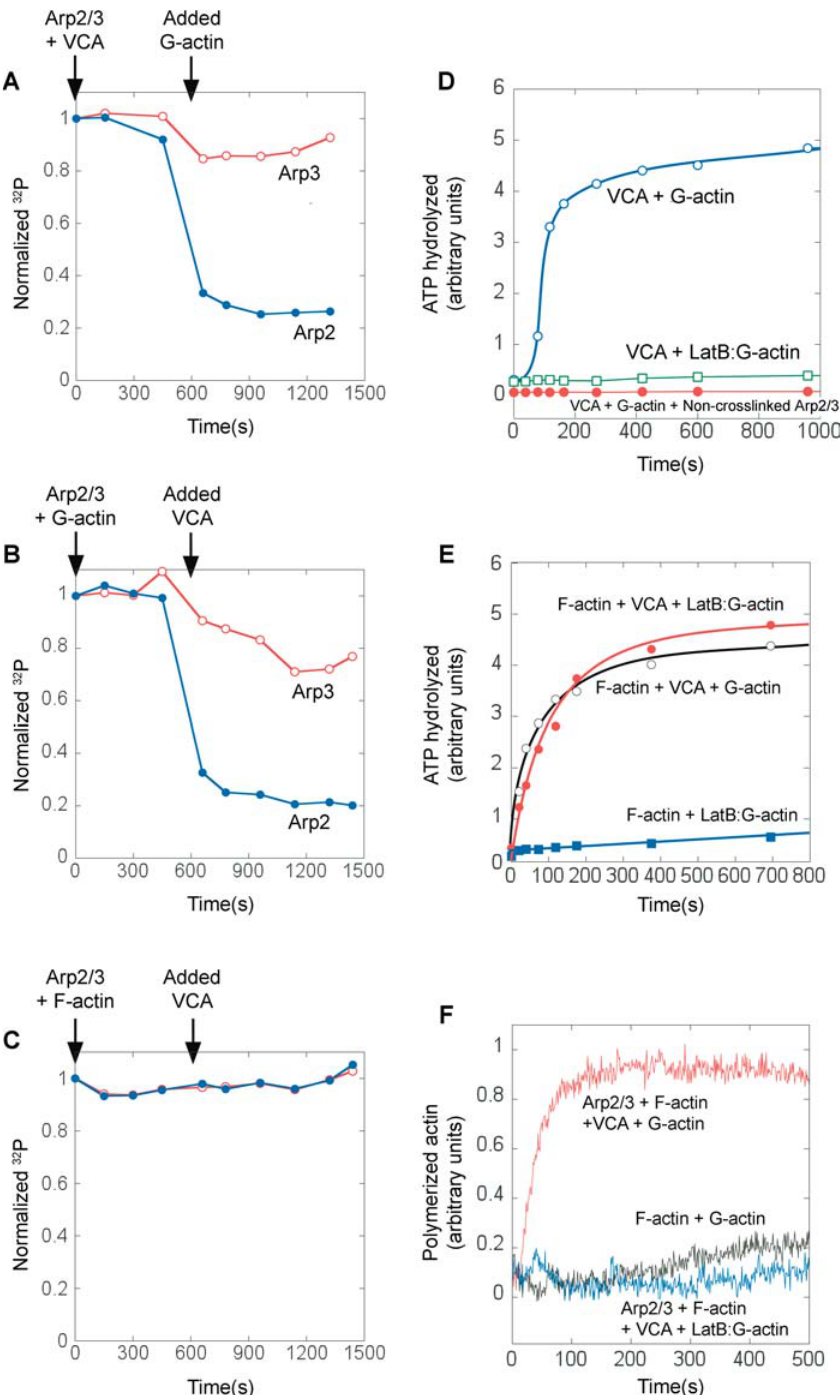
(Figure 3E, filled squares). In the presence of preformed actin filaments and VCA, however, Latrunculin B–actin monomers stimulate rapid ATP hydrolysis on Arp2/3 (Figure 3E, filled circles) without actin polymerization (Figure 3F). Table 1 summarizes the requirements for stimulation of ATP hydrol- ysis on Arp2. These data indicate that during the nucleation reaction, actin filament side-binding by Arp2/3 complex is a prerequisite for VCA and monomeric actin to stimulate ATP hydrolysis on Arp2. The observation that polymerization of